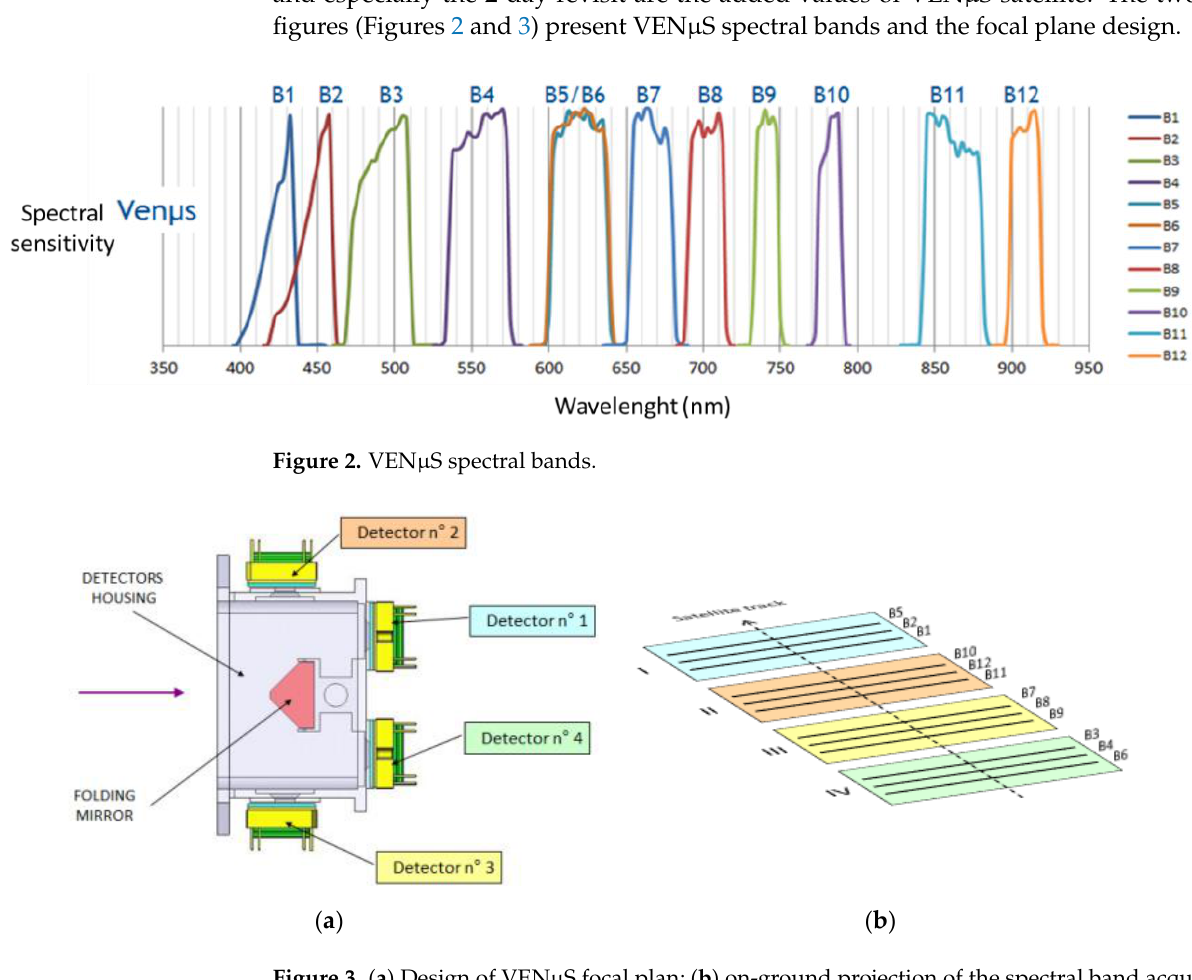
Figure 3. ( a ) Design of VEN μ S focal plan; ( b ) on-ground projection of the spectral band acquisition order.